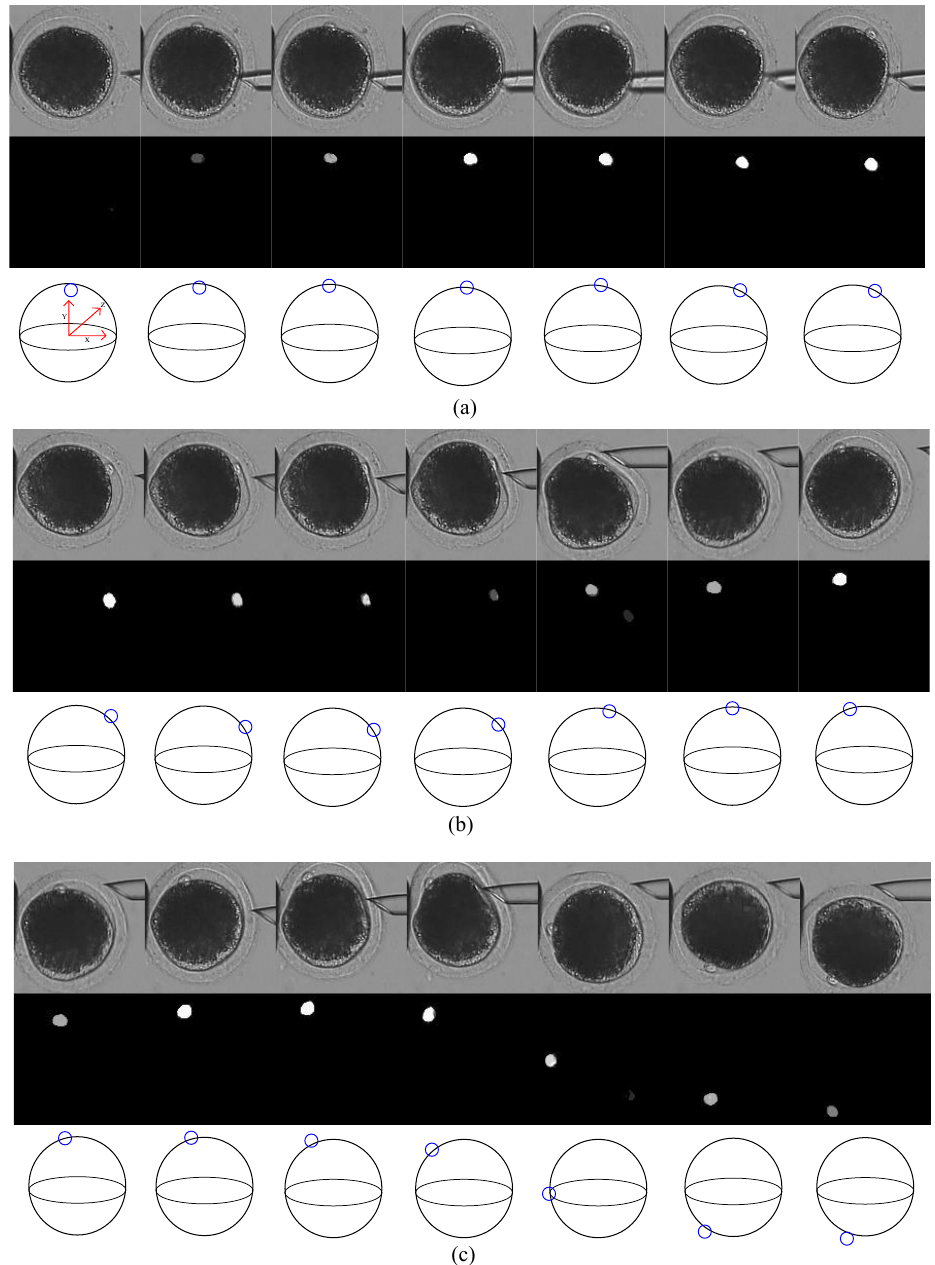
Figure 9. Polar-body-detection results during cell rotation. ( a ) In the first rotation stage, the polar body is from invisible to visible, from blurred to clear. ( b ) In the second rotation stage, the polar body is rotated to the desired position in the focal plane. ( c ) In the second rotation stage, the polar body is often deformed due to contact with the injection micropipette. For each process, the first row represents the original oocyte image. Polar bodies are in different positions along the time series of the rotation process. The second row represents the corresponding segmented map in which the brightness of the white pixel represents the confidence of the prediction. The third row represents the polar body in a 3D view in which the position of the polar body is marked by a blue